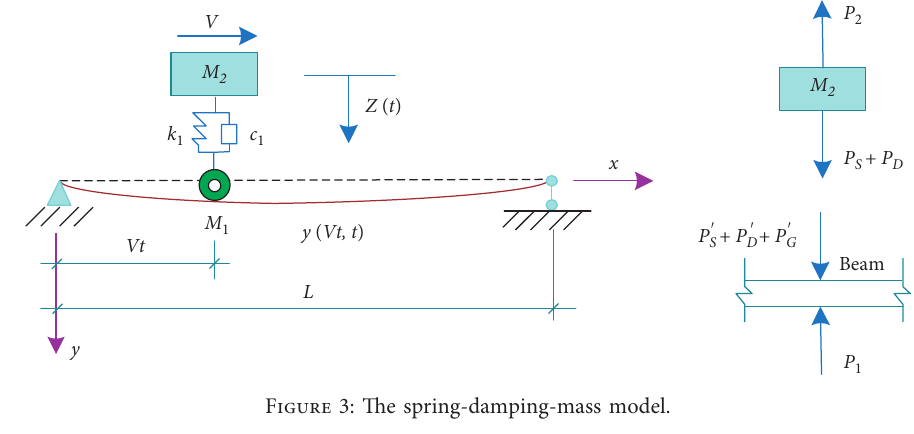
Figure 3: The spring-damping-mass